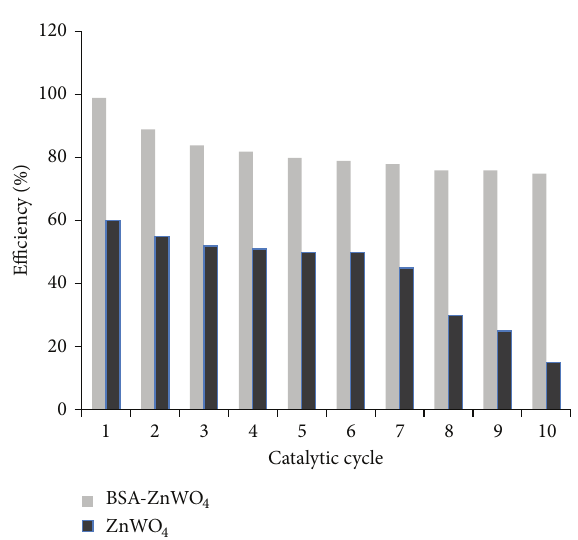
Figure 9: Recycle efficiency of BSA-ZnWO 4 and ZnWO 4 : [MB] = 6.0 × 10 −5 moldm −3 , catalyst dosage = 50mg/100 mL, pH = 5, temperature: 30 ± 0.5 ∘